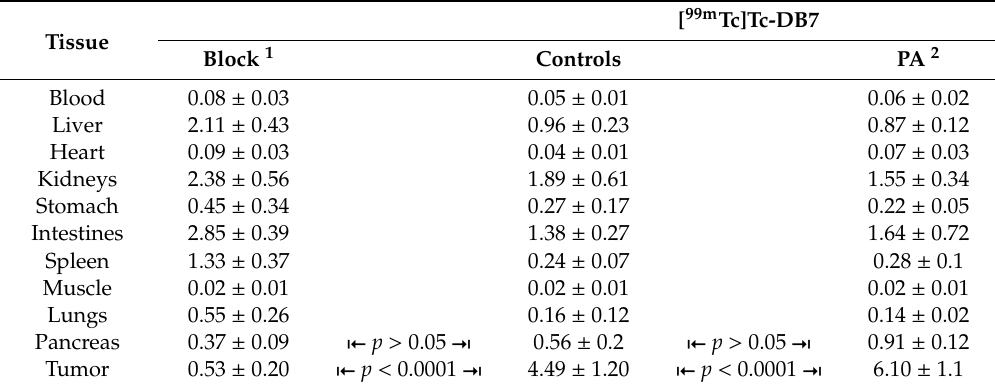
Table 1. Biodistribution data for [ 99m Tc]Tc-DB7, expressed as %injected activity per gram tissue (%IA/g) mean ± SD, n = 4, in PC-3 xenograft-bearing severe combined immunodeficiency disease (SCID) mice at 4 h pi.